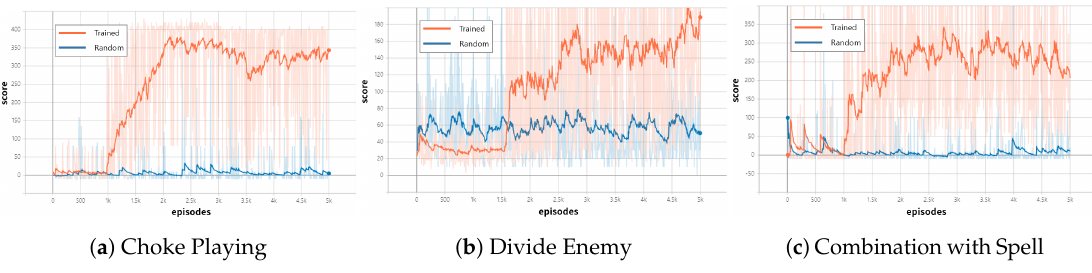
Figure 6. Integrated score graph of three minigame training methods.